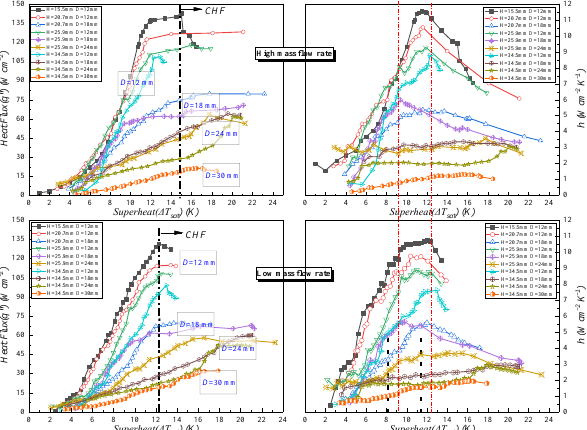
Figure 9. Heat flux and heat transfer coefficient versus superheat at over coverage. At ∆ T sat = 15 K, the high mass flow rate experimental sets entered the CHF stage, and at ∆ T sat = 12.5 K, the low mass flow rate experimental sets entered the CHF stage. At 9 K < ∆ T sat < 12.5 K, the heat transfer coefficient reached the maximum. For high mass flow rate at ∆ T sat < 6 K (low mass flow rate at ∆ T sat < 5 K), the heat flux increased slowly with an increase in the superheat, and at 6 K < ∆ T sat < 12 K (low mass flow rate at 5 K < ∆ T sat < 12.5 K), the heat flux increased rapidly with an increase in the superheat. In particular, for different mass flow rates, with an increase in the heat sink surface diameter, the growth rates of the heat flux and superheat gradually decreased. Similar to the case of incomplete coverage, the two parameters, namely spray height and heat sink surface diameter, could be divided into four levels depending on the extent of increase in the heat sink diameter. Therefore, the influence of the heat sink surface diameter on the heat transfer was greater than that of the spray height.